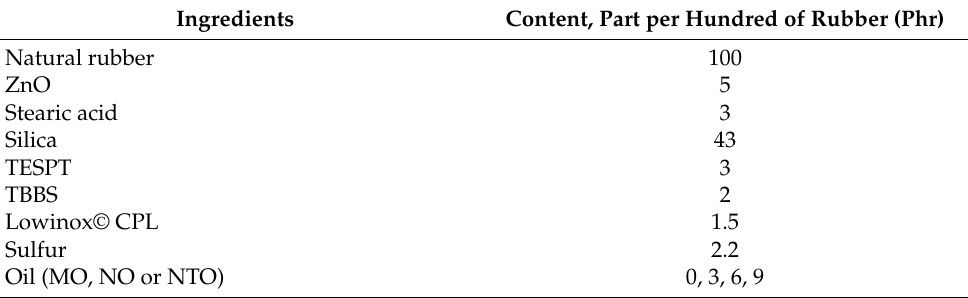
Table 2. The compound formulations used in the present